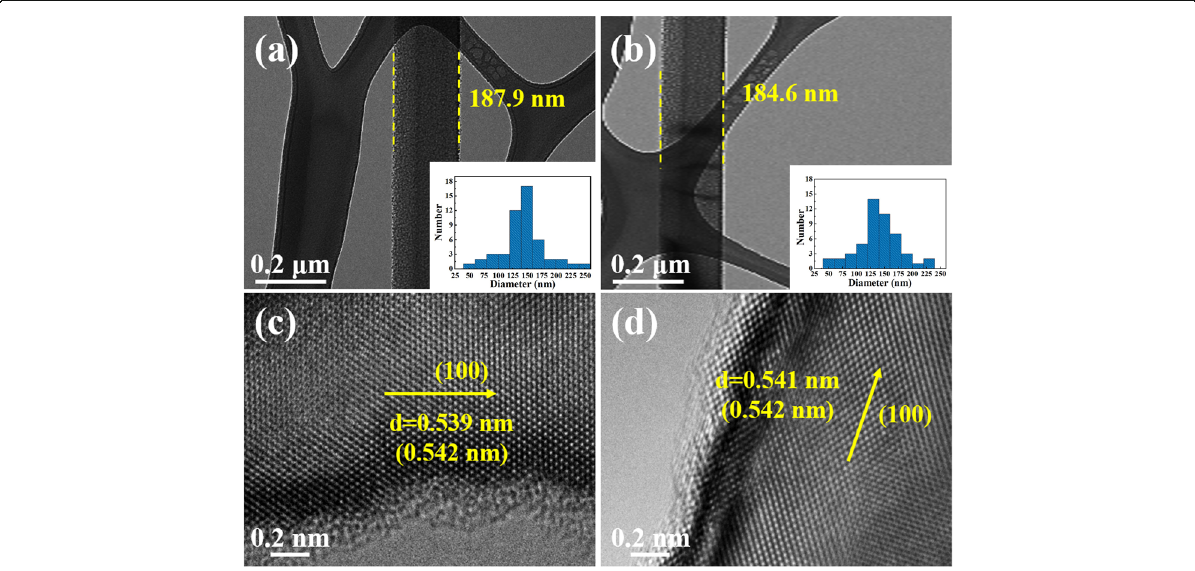
Fig. 2 TEM and HRTEM images of catalysts: a and c p-type Si NWs b and d n-type Si NWs illustrations are the normal distributions of diameter corresponding to the p (100) NWs and n (100) NWs, respectively